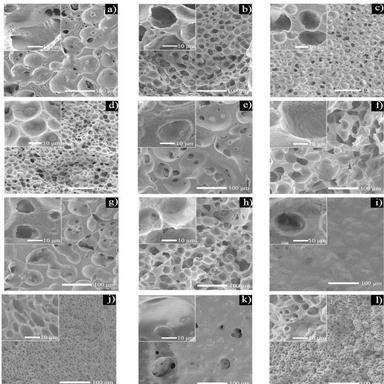
SEM images of a) PLACHLX surface, b) PLACHLX cross-section, c) PLA-CHLA surface, d) PLACHLA cross-section, e) PLADCMX surface, f) PLADCMX crosssection, g) PLADCMA surface, h) PLADCMA cross-section, i) PLAF CHLX surface, j) PLAF CHLX cross-section, k) PLAF CHLA surface, and l) PLAF CHLA cross-section.